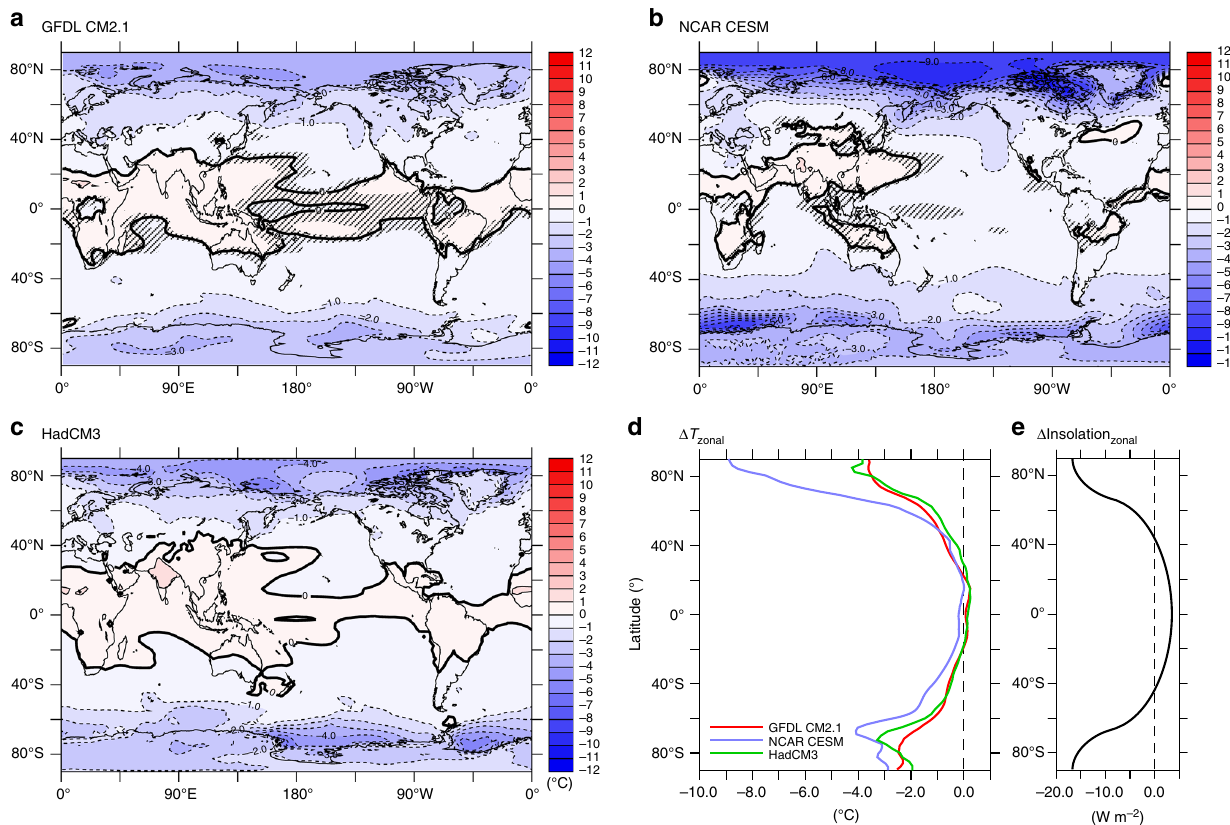
Fig. 1 Modeled temperature response to obliquity. Annual mean surface air temperature anomaly (°C) for a CM2.1, b CESM, and c HadCM3 for the low – high obliquity experiments. Annual, zonal-mean anomalies for d surface air temperature and e insolation. In ( a ) and ( b ), hatching indicates anomalies which are not signi fi cant at a 0.05 level according to a two-tailed t -test (i.e., the means of the two 100-year model outputs are not found to be signi fi cantly different). Surface air temperature is calculated at 2 m for CM2.1 and CESM and 1.5 m for HadCM3. Global mean temperature anomalies are − 0.54 °C for CM2.1, − 1.07 °C for CESM, and − 0.48 °C for